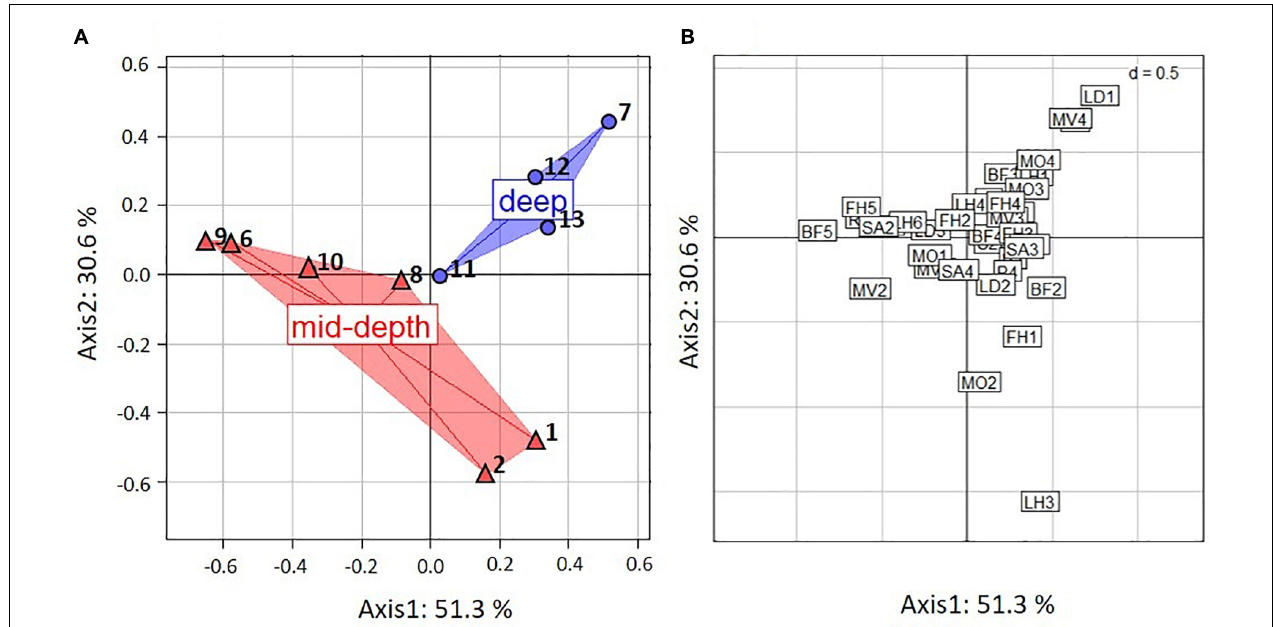
FIGURE 3 | Results of fuzzy correspondence analysis (FCA) on the biological traits of epifauna from the Chukchi Borderland weighted by taxa proportional abundances from ROV samples, (A) ordination by stations, where numbers are station numbers, (B) ordination by traits, where trait modality codes are abbreviated by two letter-one number combinations and explained in Table 2 . Red – mid-depth stations. Blue – deep stations.